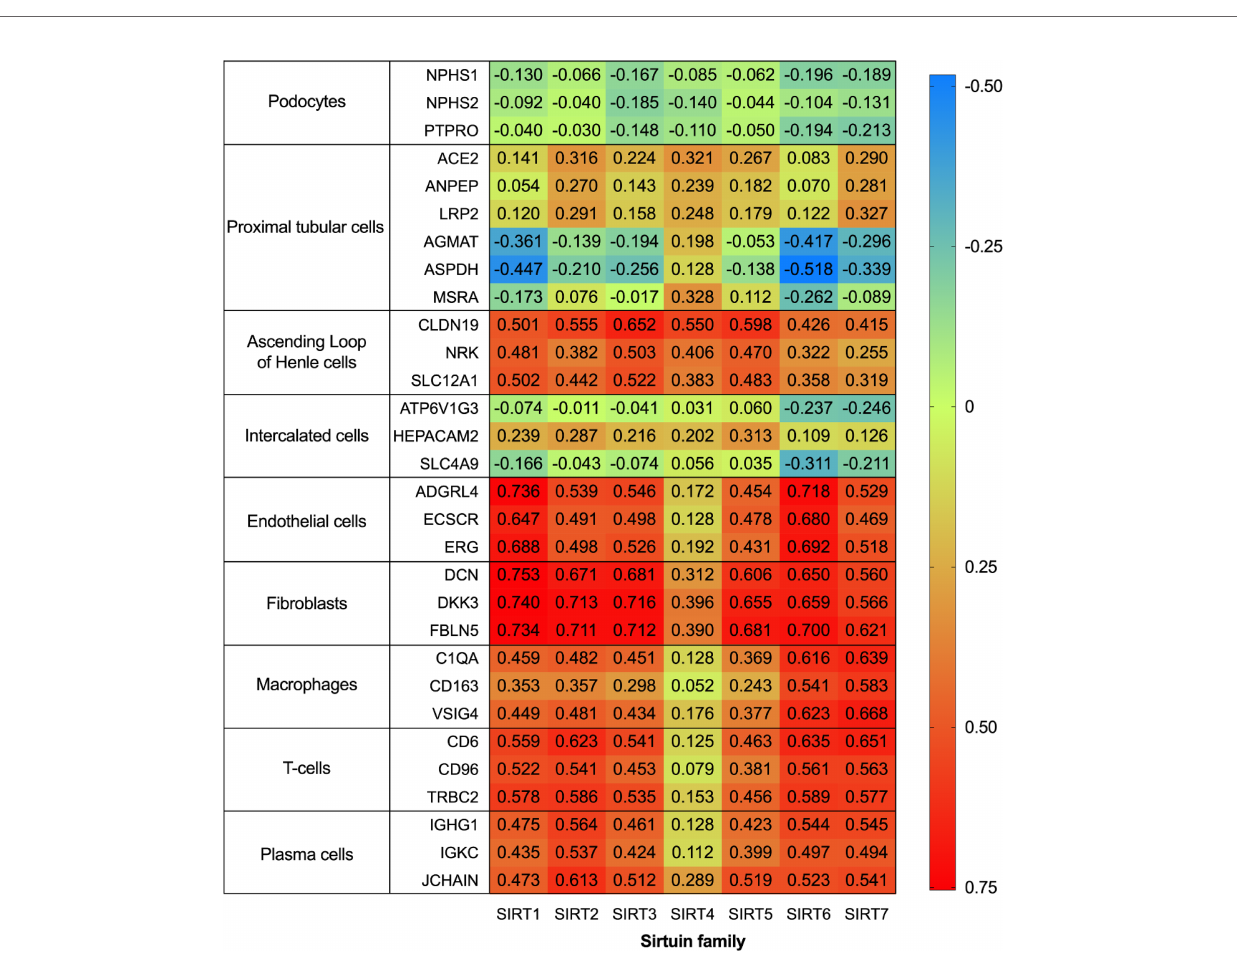
FIGURE 4 | Correlation of human Sirtuin family transcriptome in renal tissues. The analysis was performed on data from RNA-seq of unfractionated tissue samples, which contained a mixed cell population. Across the respective sample sets the reference transcripts within each cell type panel correlated highly with each other, but not with those in the other panels. An integrative co-expression analysis was performed to determine the expression pro fi le of each gene; genes highly correlated with all transcripts in only one reference panel were classi fi ed as enriched in that cell